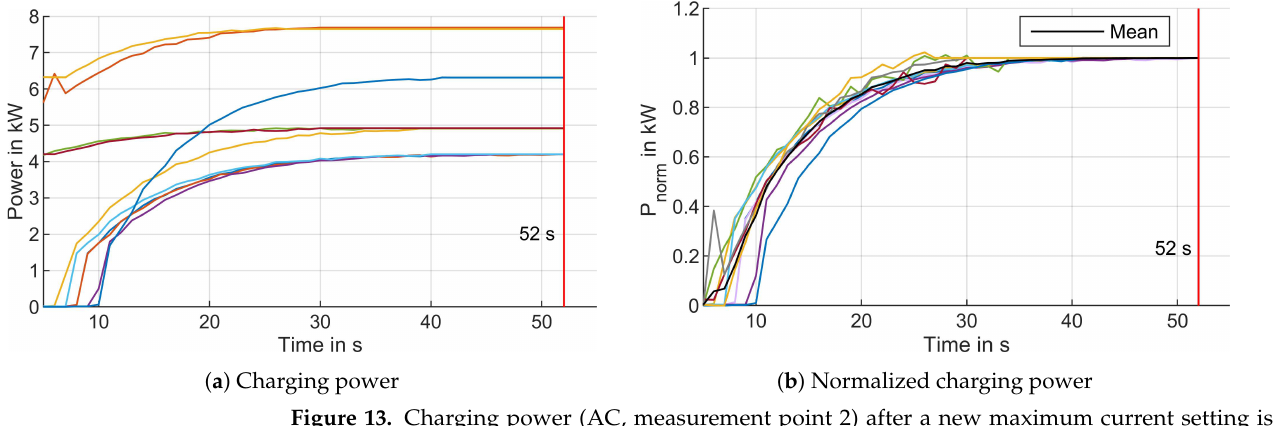
Figure 13. Charging power (AC, measurement point 2) after a new maximum current setting is communicated to the EV via the CP at time t = 0s. Each colored line is one measurement and in ( b ) the black line illustrates the mean of all normalized charging power measurements. After 52s the new charging power setting is reached by the